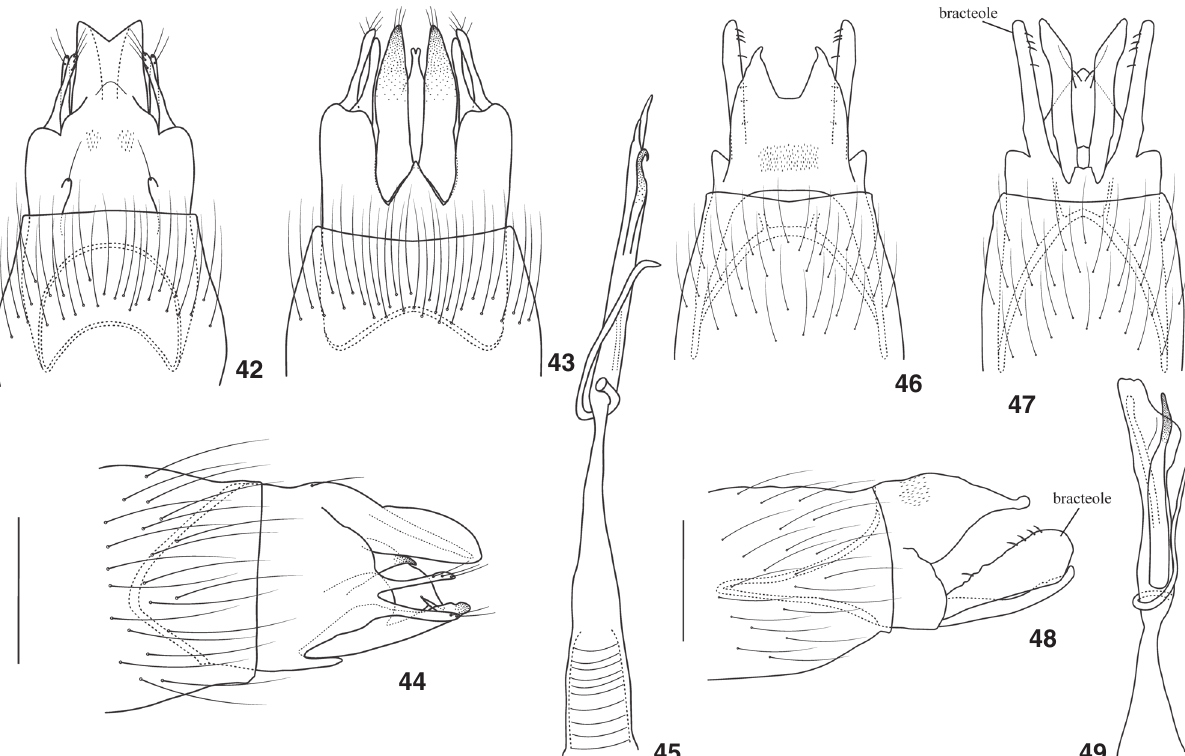
Figures 42-49. Male genitalia. (42-45) Neotrichia pelei sp. nov. : (42) dorsal; (43) ventral; (44) left lateral; (45) phallus, dorsal. (46-49.) Neotrichia feolai sp. nov. male genitalia: (46) dorsal; (47) ventral; (48) left lateral; (49) distal portion of the phallus, dorsal. Scale = 0.1